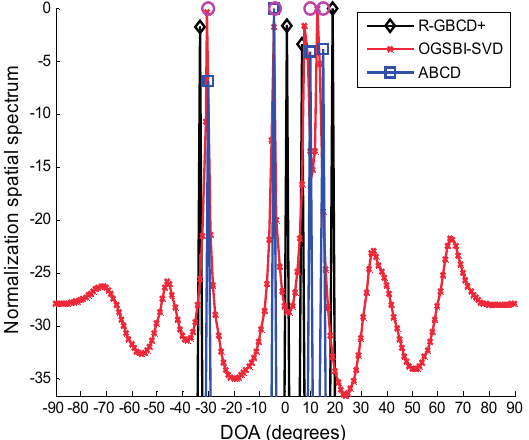
Figure 1. Spatial spectra of R-GBCD+, OGSBI-SVD and ABCD, where the pink circles denote the true DOAs.